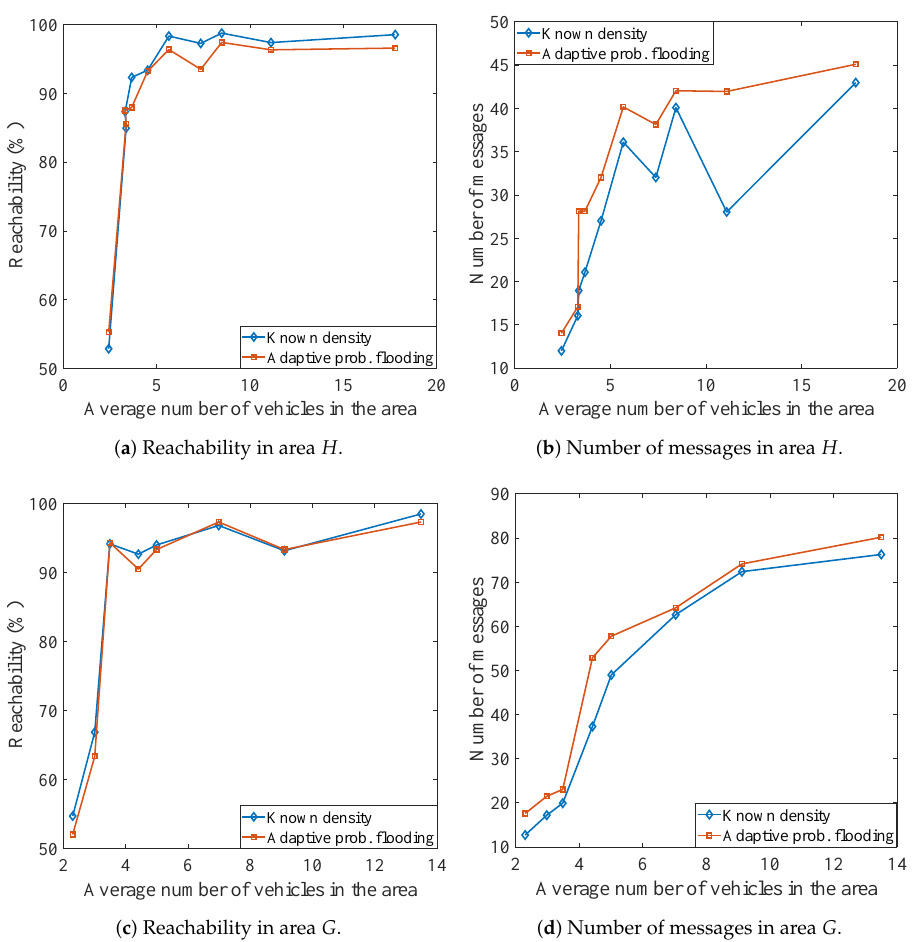
Figure 12. Comparison of the proposed hovering scheme with a protocol which assumes the vehicle density within the hovering area to be known. The comparison is made in terms of the reachability achieved and the number of messages exchanged in areas H and G for different average number of vehicles in the